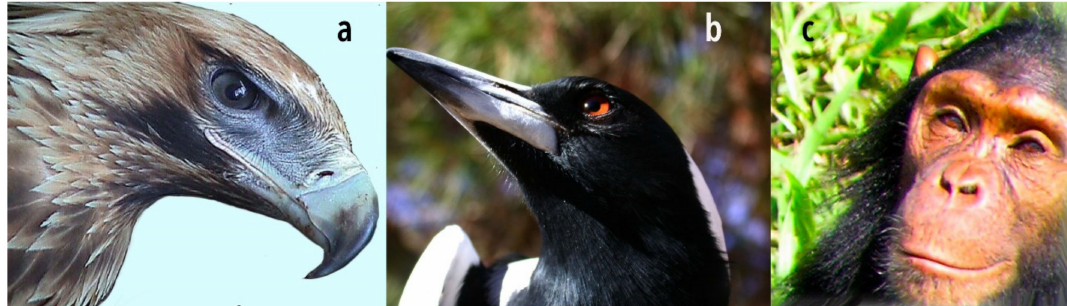
Figure 4. Caption: The heads of ( a ) a juvenile wedge-tailed eagle ( Aquila audax ) and ( b ) of an adult Australian magpie ( Gymnorhina tibicen ). The strong beak of the eagle and the eyes set deep under a protruding brow, make the bird appear dangerous and give the eyes an almost hostile appearance; and the powerful beak is often misjudged as a weapon. That is mostly incorrect. The beak is so strong in order to tear open mammalian hides, not for fighting and biting. The business end and the “weapon” are its talons. The magpie, even with its soft brown eyes, still has a remarkably strong beak and, in this species, the beak is indeed used for fighting and for administering punishment to intruders or unruly youngster. Neither face may give us readily identifiable cues about mood or intentions. By contrast ( c ): A face of a chimpanzee in the Ngamba Sanctuary in Uganda seeing a friend approach—a relaxed face (squinting